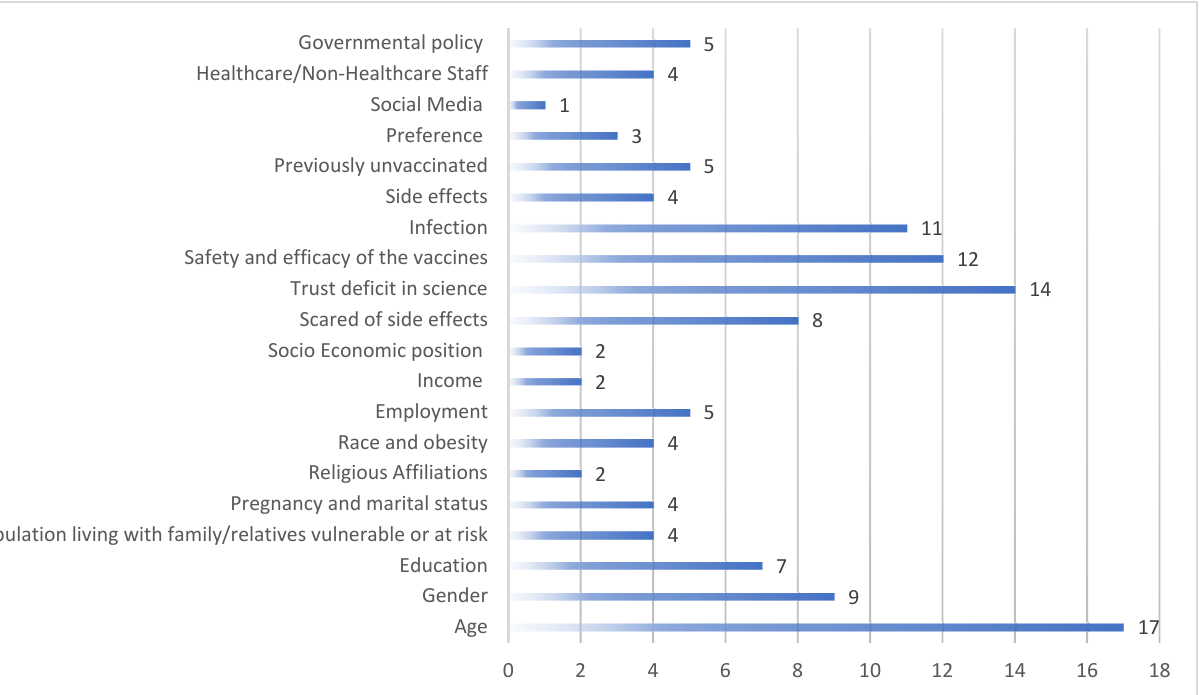
Figure 2. Graphical representation of number of articles attributing factors responsible for VBH.